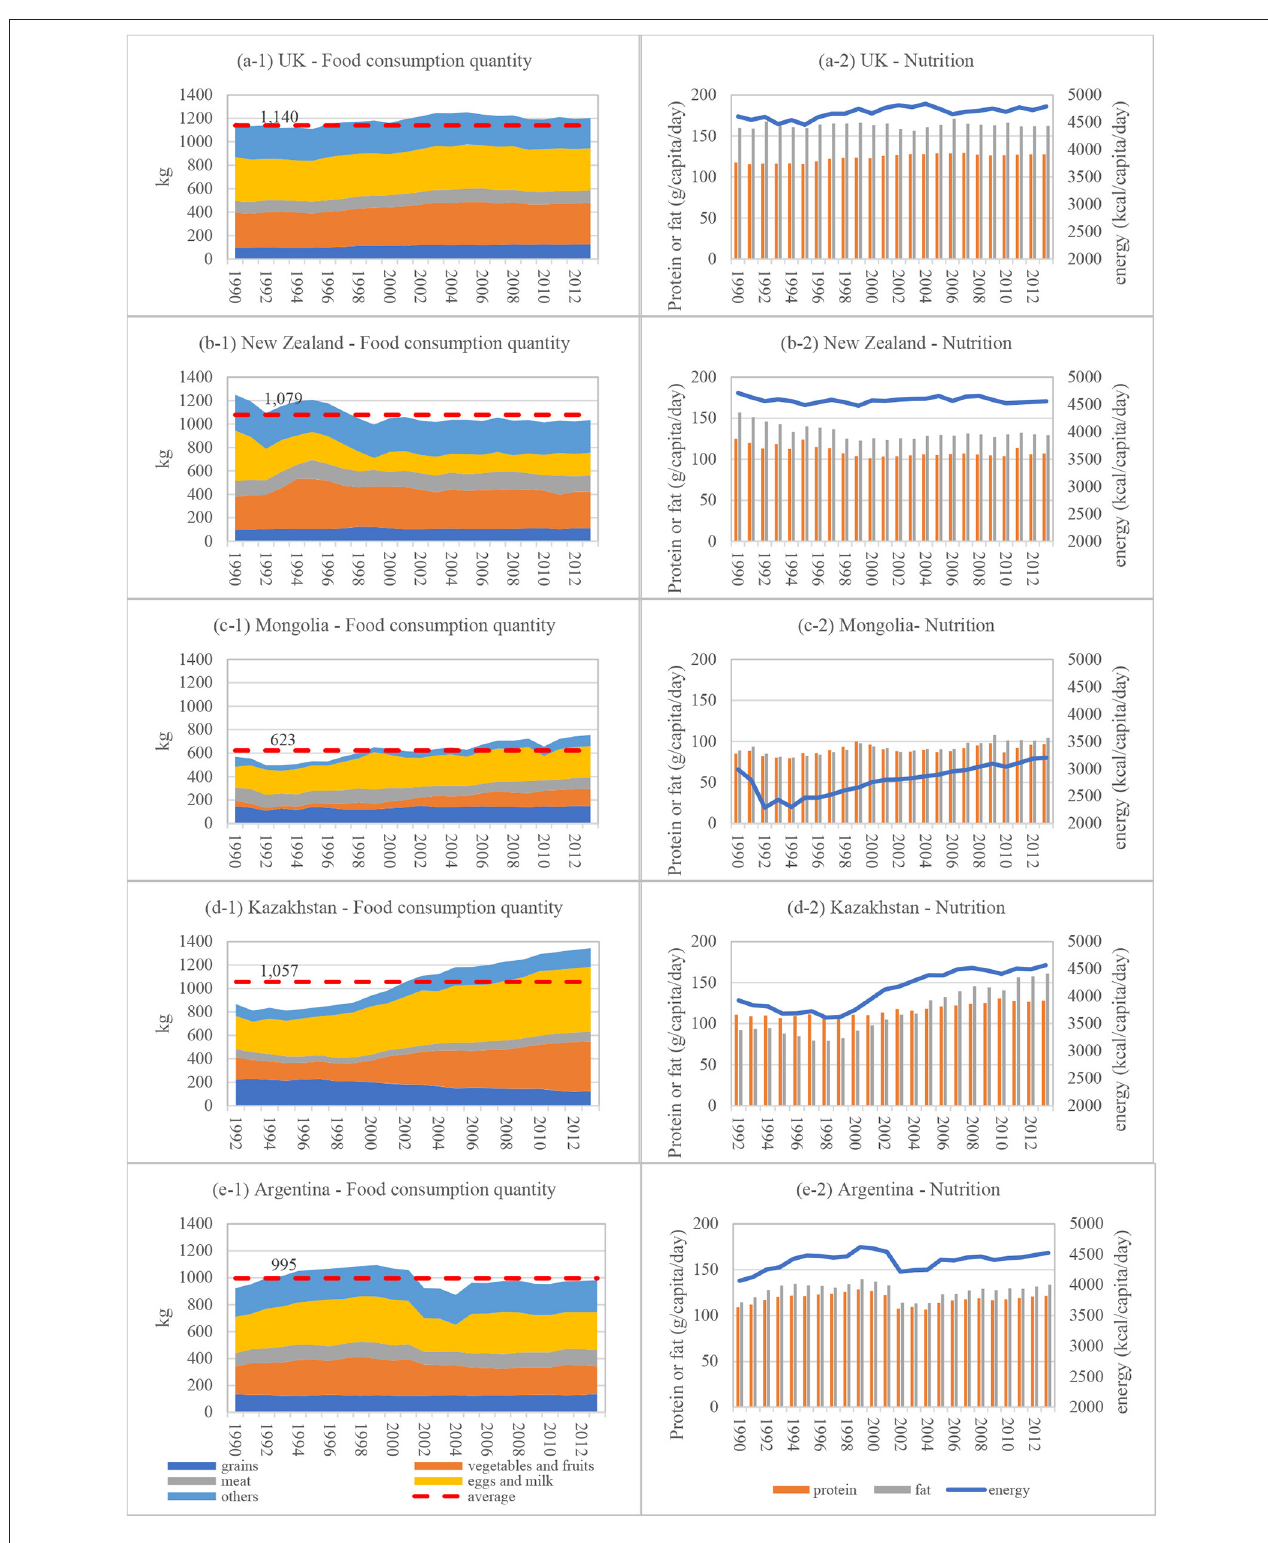
FIGURE 5 | Food consumption and nutritional structure of residents in other typical grassland countries or regions. Data source: FAO database (http://www.fao.org/faostat/en/#data). (A-1) UK—food consumption quantity, (A-2) UK—nutrition, (B-1) New Zealand—food consumption quantity, (B-2) New Zealand—nutrition, (C-1) Mongolia—food consumption quantity, (C-2) Mongolia—nutrition, (D-1) Kazakhstan—food consumption quantity, (D-2) Kazakhstan—nutrition, (E-1) Argentina—food consumption quantity, (E-2) Argentina—Nutrition.